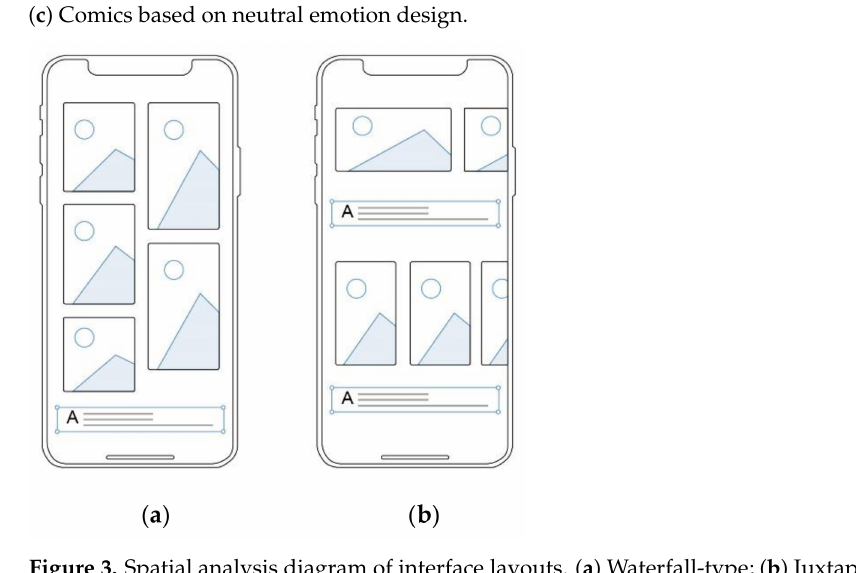
Figure 3. Spatial analysis diagram of interface layouts. ( a ) Waterfall-type; ( b )